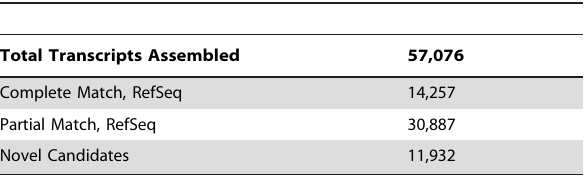
Table 2. Reference-Guided Assembly of RNA-Seq Reads into Transcripts by Cufflinks a